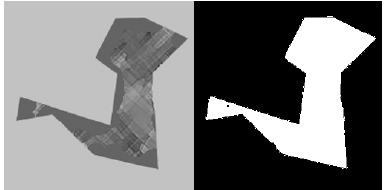
Figure 4. One of the database images and its template mask for detecting the background.